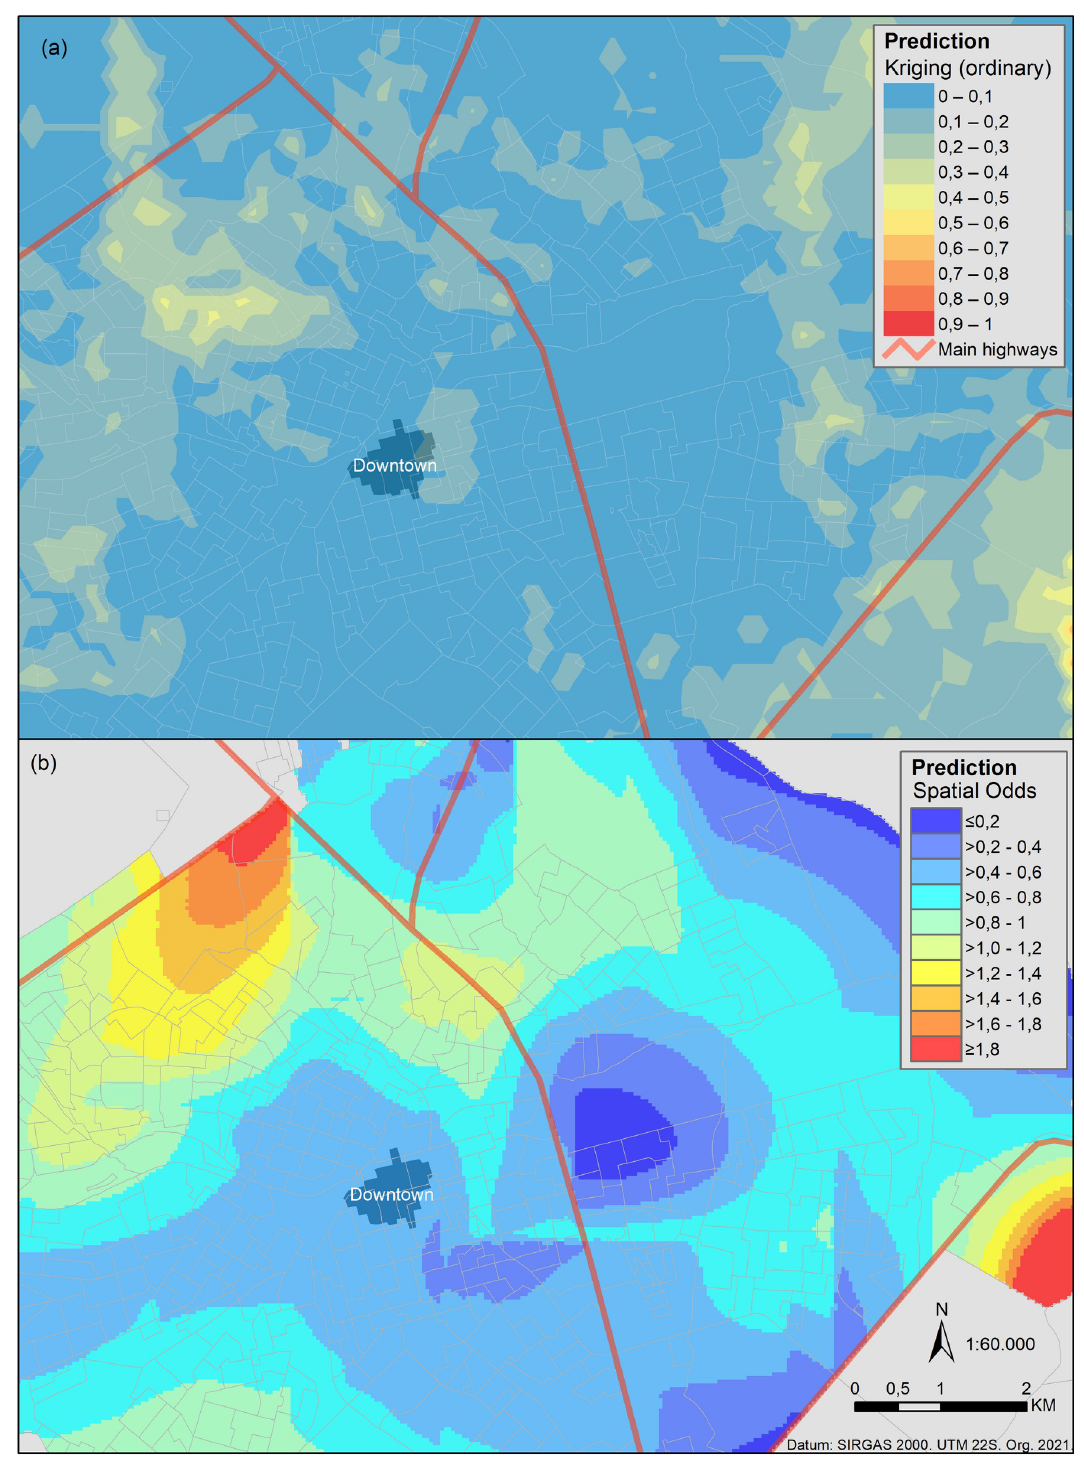
Fig 6. Predicting the risk for canine visceral leishmaniasis using geospatial methods. Spatial prediction models using the dog population. Risk is scaled from low (blue) to high (red), as shown by the legends. (a) Geostatistical approach using the ordinary Kriging method. (b) Generalized additive